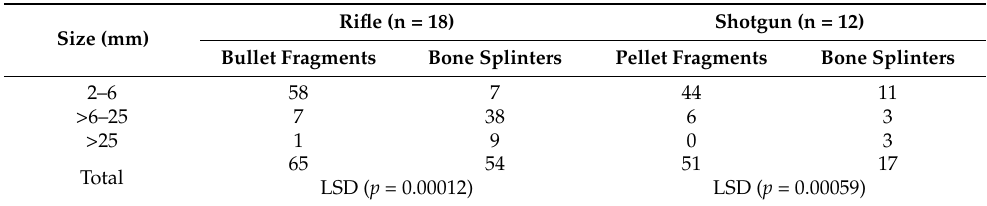
Table 1. Size and quantity of bullet fragments and bone splinters found between the two killing